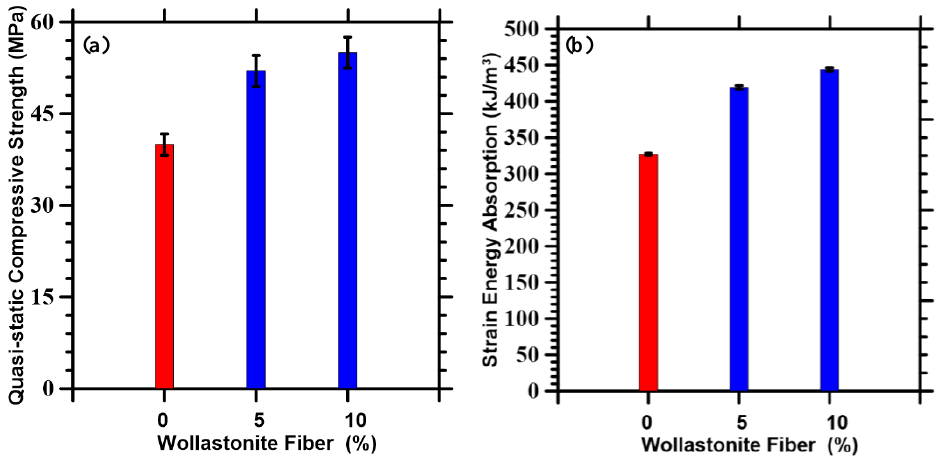
Figure 3. ( a ) Quasi-static compressive strengths and ( b ) strain energy absorption of control (shown in red) and wollastonite fiber-reinforced mortars (shown in blue).